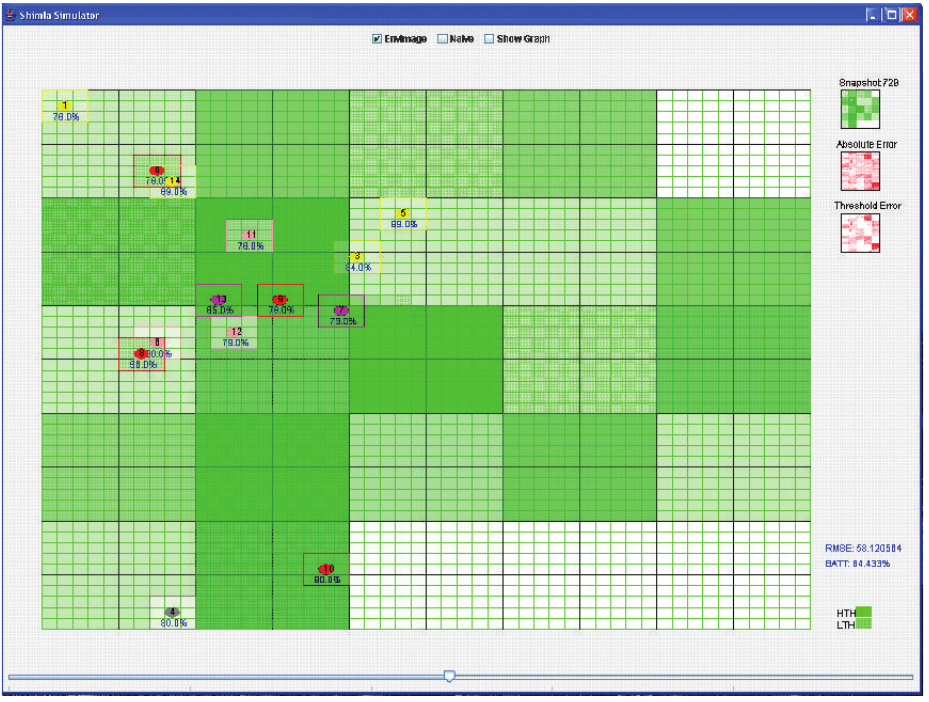
Figure 4: Shimla simulator.